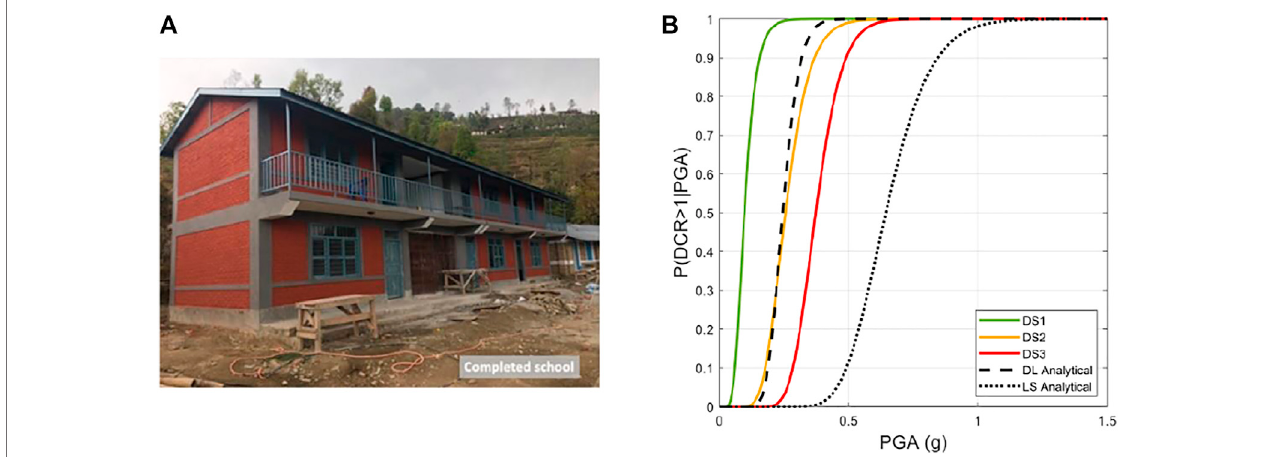
FIGURE8 | (A) Photograph ofrealised schoolbuilding(Cross et al. 2020); (B) Fragility curves for DS1, DS2, and DS3 (this study) and DL and LS limit states (Cross et al. 2020).